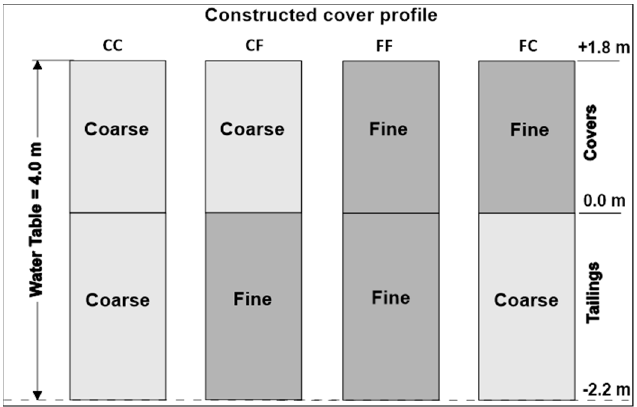
Figure 5. Representative cover profiles used for numerical modeling (Modified from Dobchuk et al. 2013) [10].